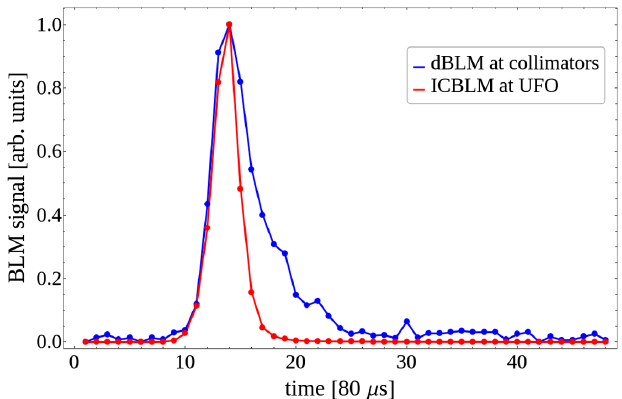
FIG. 13. Integrated signal for the 12 bunch train, each bunch individually. The horizontally blown-up bunch (black) shows a significantly larger signal throughout, and is also detected earlier than the other